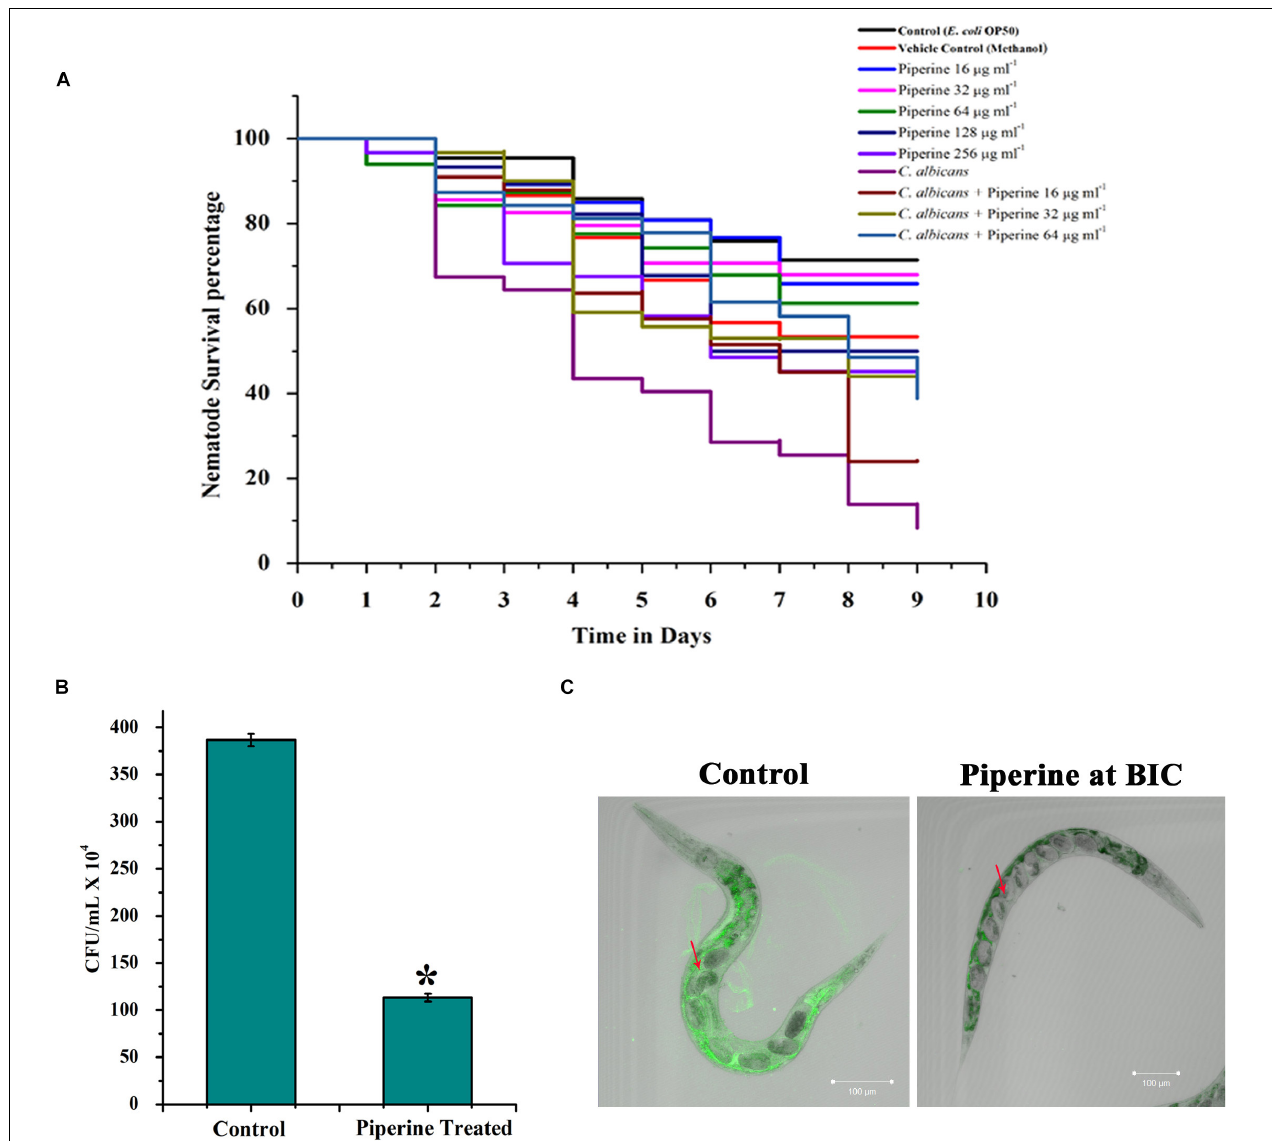
FIGURE 9 | In vivo efficacy of piperine on survival and rescue of C. elegans from C. albicans infection. (A) Toxicity effect of piperine and the potential for rescuing C. elegans from C. albicans infection. (B) Effect of piperine on in vivo colonization of C. albicans in C. elegans. Number of C. albicans colonized on C. elegans was assessed by cfu and (C) CLSM micrographs showing reduced colonization of C. albicans inside the nematode. The arrow mark in the left panel (Control) shows the deformities and internal hatching of eggs due to the pathogenicity of C. albicans. Red arrow in the right panel (treated) denotes the healthy eggs in C. elegans rescued from C. albicans infection by piperine at 32 µ g mL - 1 concentration. Error bars represent standard deviations from the mean ( n = 3). * p <